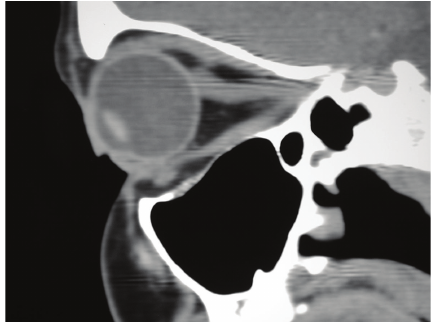
Figure 2: Parasagittal view showing normal right orbital contents.